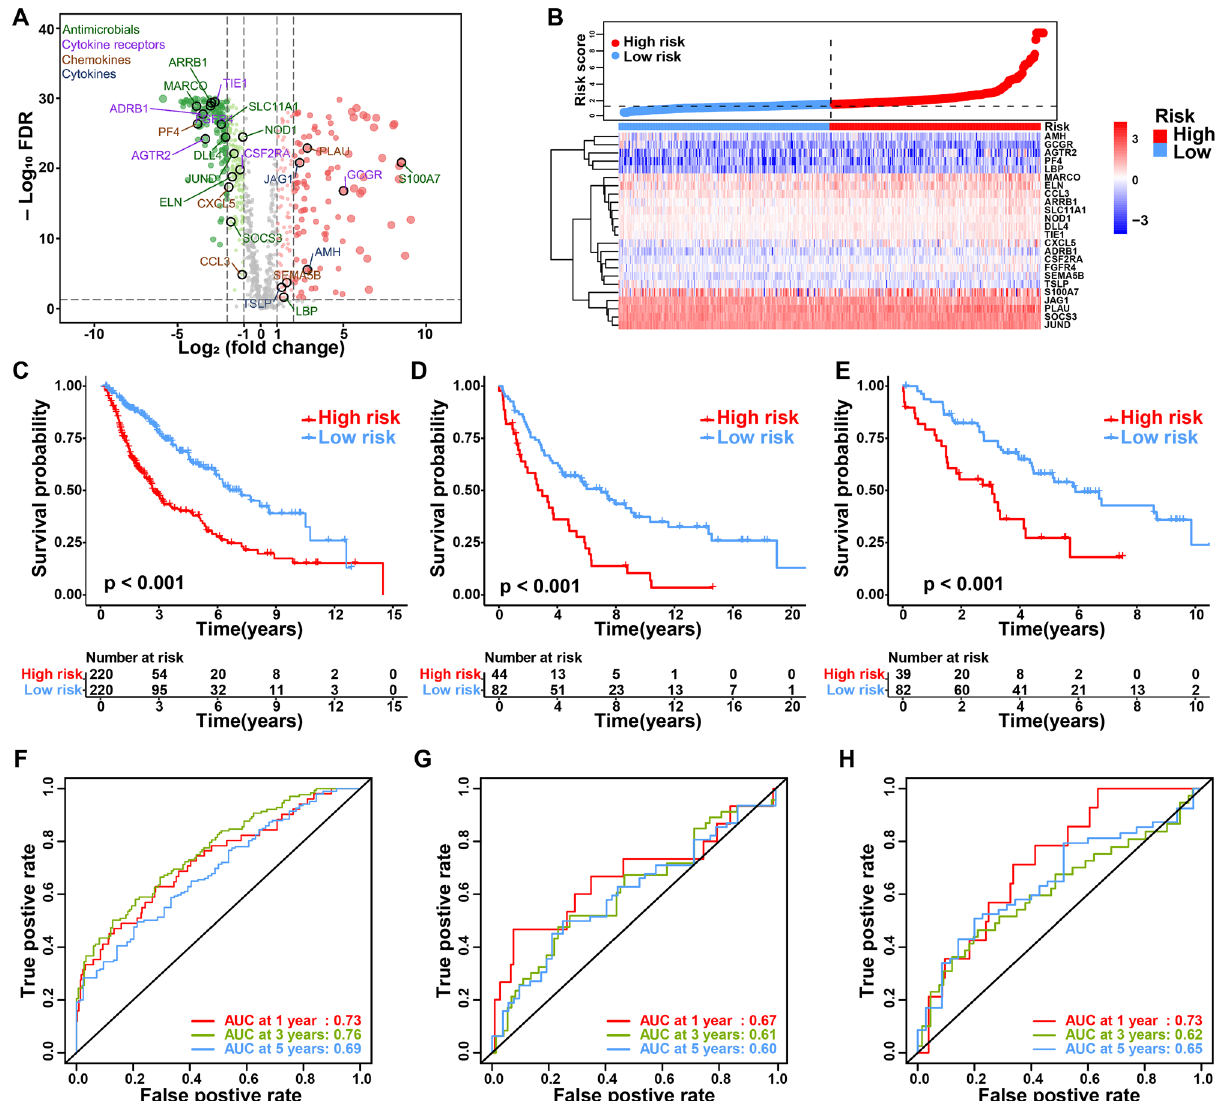
Figure 1. Prognostic analysis of the IPM. ( A ) Volcano plot of differentially expressed IRGs between tumor and normal tissues. Twenty-four candidates selected for the construction of the IPM are indicated. Gene categories associated with the immune process are shown in different colors. ( B ) Distribution of risk score and gene expression normalized by Z-score. Kaplan–Meier plots and time-dependent ROC curves according to the IPM in the training set ( C , F ), validation set 1 ( D , G ) and validation set 2 ( E , F ). ( C – E ) Patients in the high-risk group suffered shorter overall survival (p < 0.001, log-rank test). ( F – H ) Time-dependent ROC curve validation of the prognostic value of the